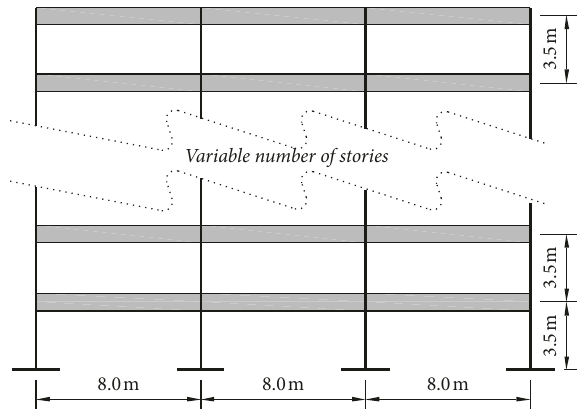
Figure 1: Geometrical characteristics of the